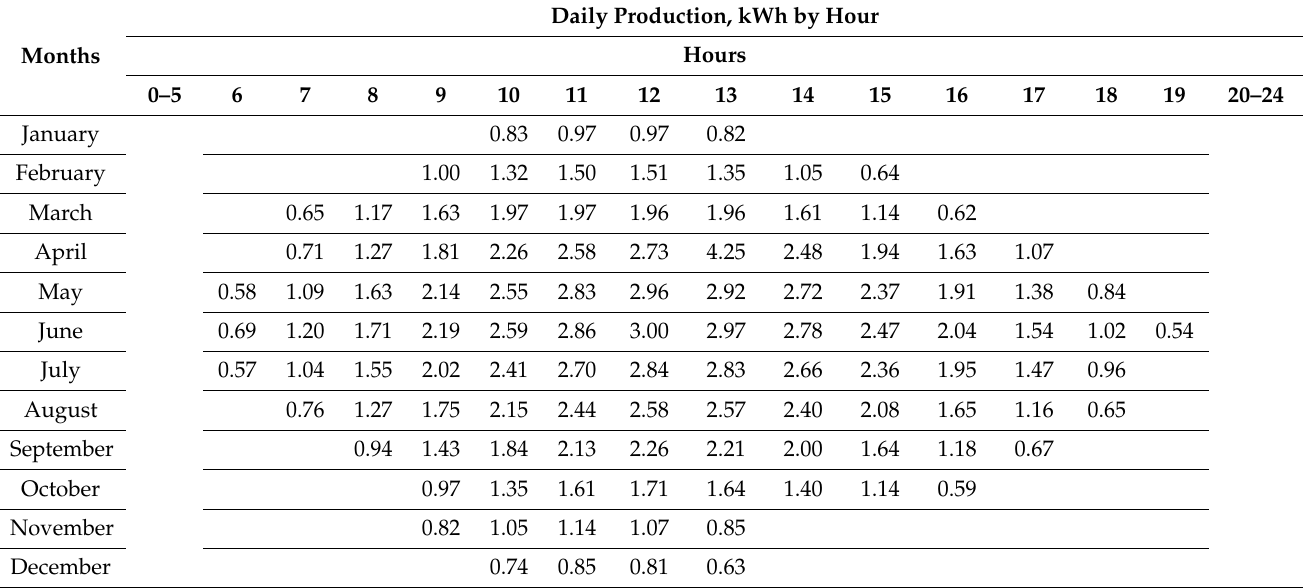
Table 15. Hours during which the power generated by the designed photovoltaic system will be sufficient for effective use of the refrigerator (without taking into account system degradation).